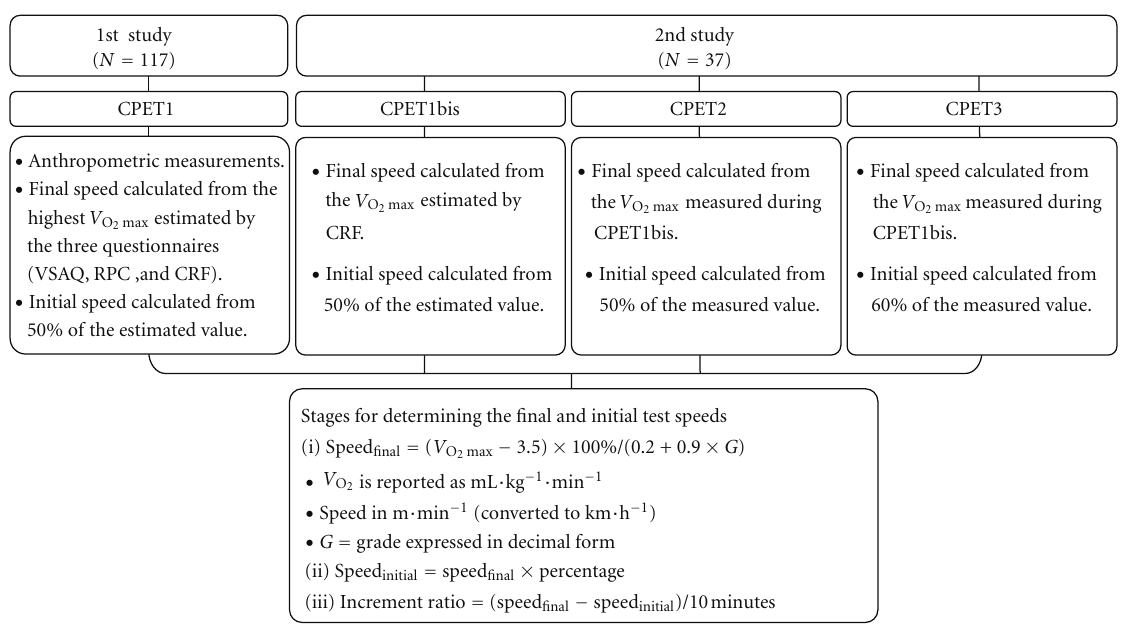
: maximal oxygen uptake; CPET: 2 max